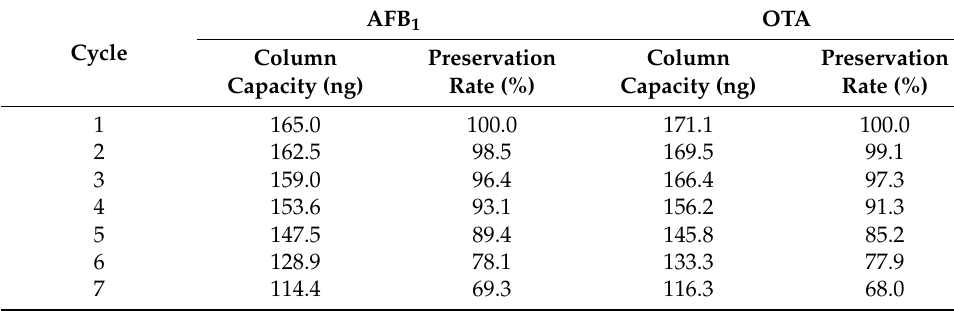
Table 3. Column capacity and preservation rate of AFB 1 and OTA in 7 cycles ( n = 3).